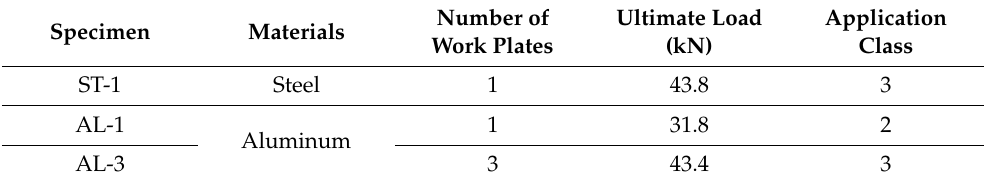
Table 19. Construction of the work class of the specimen based on the experimental results.